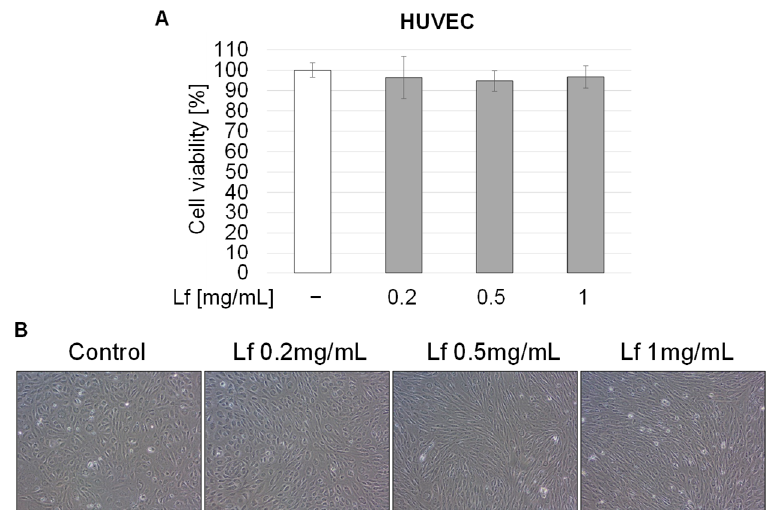
Figure 6. Effect of rhLf on viability of human endothelial cells. ( A ) Confluent HUVEC cells were cultured in the presence of indicated concentrations of rhLf (Lf). Cell viability was quantified by a WST assay after 72 h. The data are expressed as the mean ± SD of three experiments performed in duplicate. ( B ) Visualization of the effect of rhLf on confluent and morphology of HUVEC cells. Representative phase-contrast cell images are shown after 72 h treatment (100× magnification).